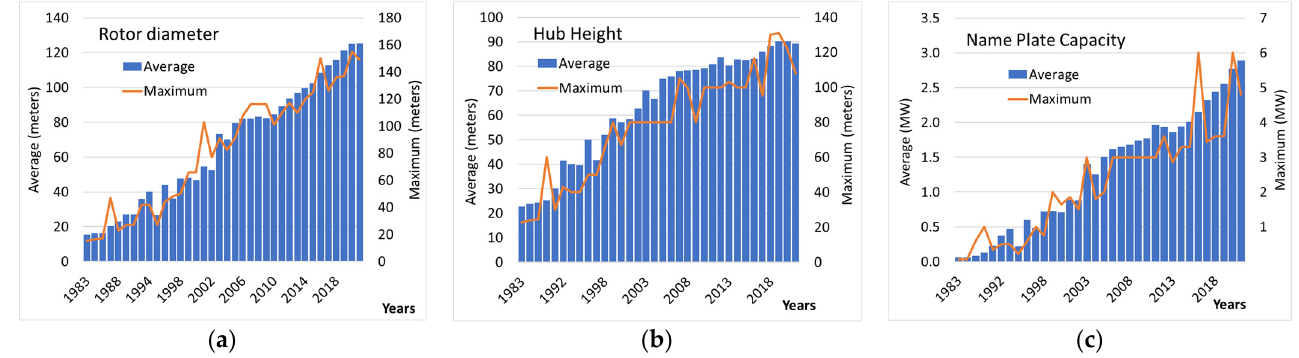
Figure 3. Wind turbine growth over time considering: ( a ) rotor diameter ( b ), hub height, and ( c ) name plate capacity.